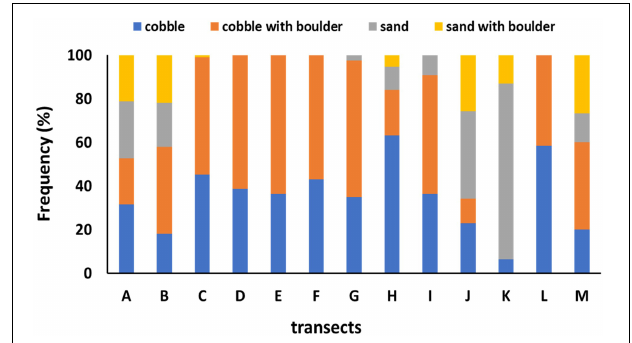
FIGURE 5 | Overview of substrate types in each of the thirteen transects.